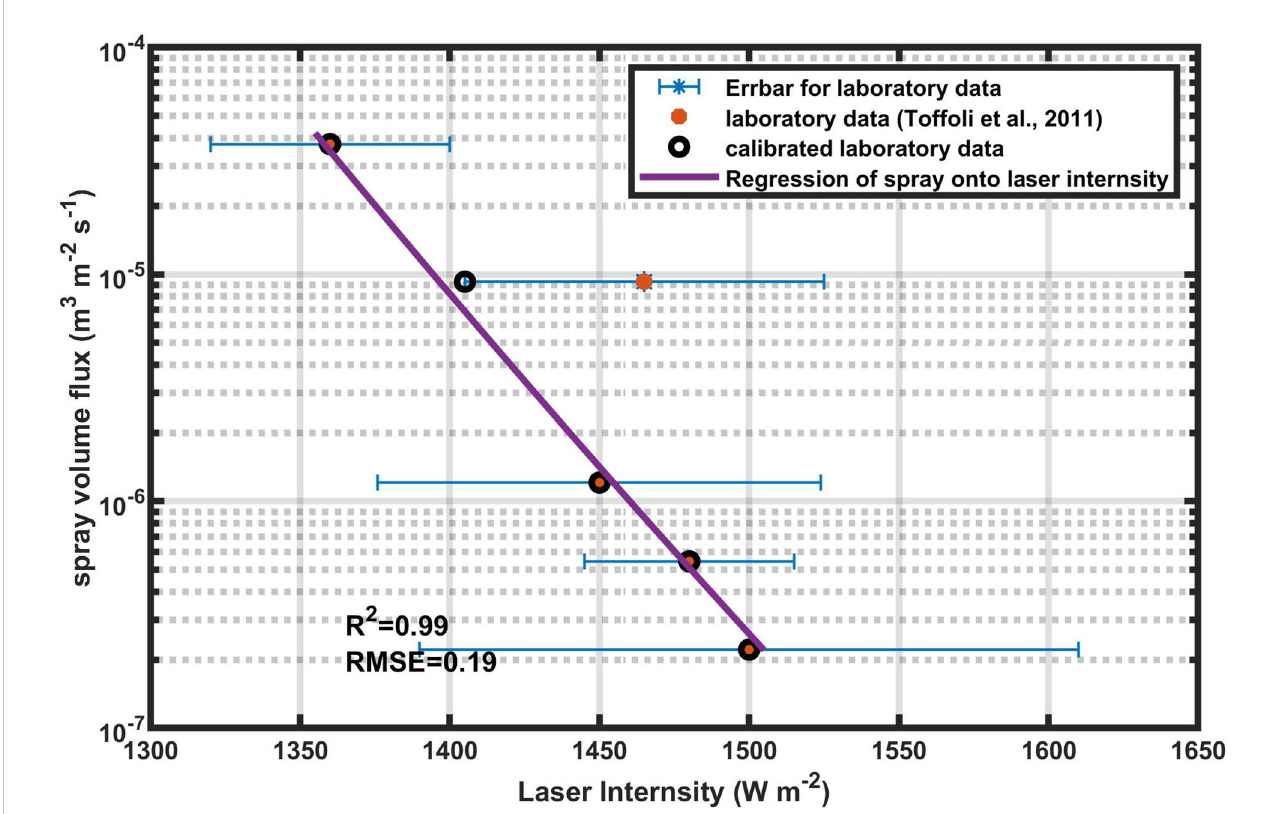
FIGURE 4 Regression of spray volume fl ux onto the laboratory laser intensity greater than 1360 W m -2 (Equation 8). Orange stars and their error bars are the observations in Toffoli et al. (2011), and black circles are the data used in the